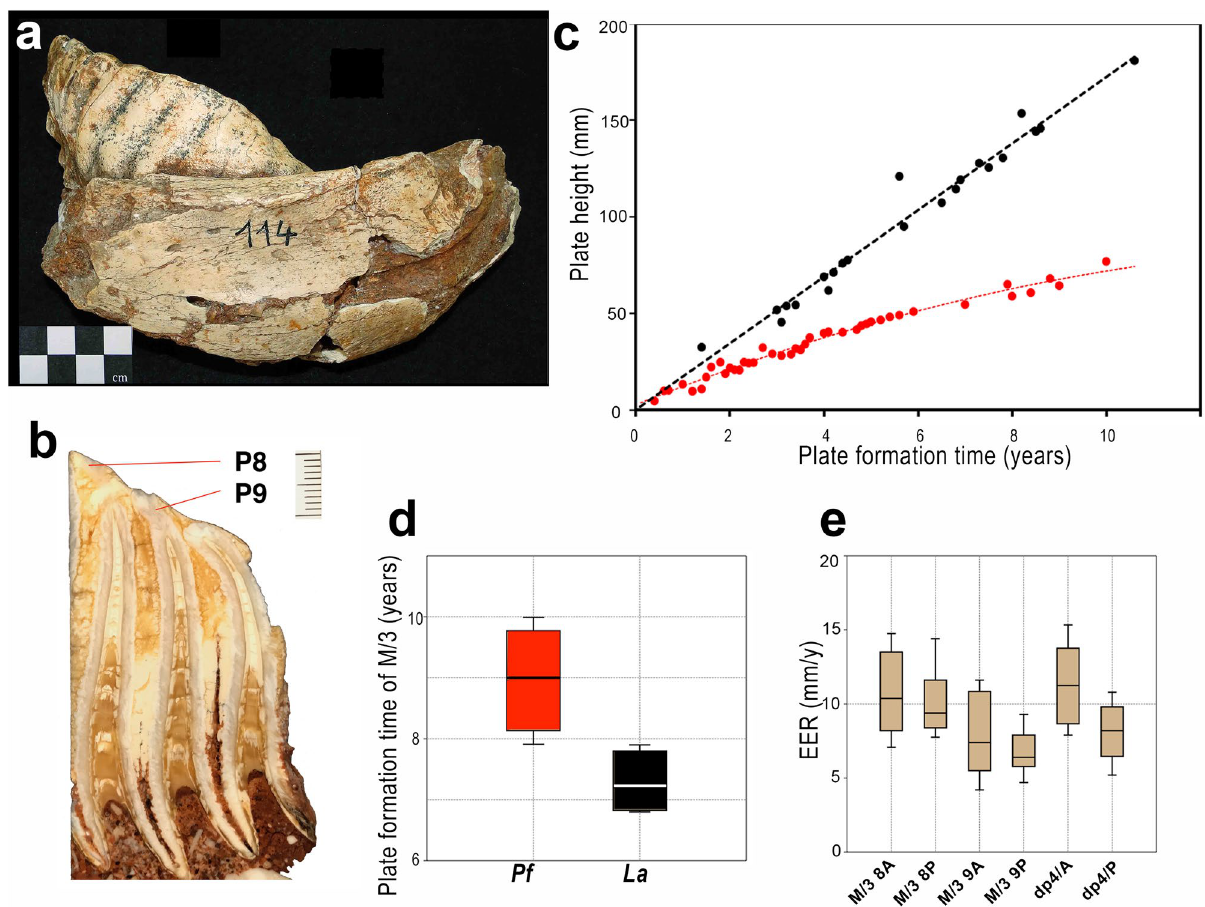
Figure 6. Molar growth pattern in P. falconeri . ( a ) Fragment of lower mandible with the P. falconeri M/3 (CAT- 114) used in molar analysis (graphic scale 4 cm); ( b ) longitudinal section of the posterior part of M/3 (CAT-114) showing the measured plates 8 and 9 (Graphic scale 1 cm); it is still unworn, roots are closed. ( c ) Growth in plate height plotted against PFT (years) for upper and lower dentition together; black dots: continental elephants ( M. columbi 32 ; P. antiquus IPS-B1-L1-82167, the last supposed sister taxon of both insular taxa P. cypriotes and P. falconeri ); red dots: insular elephants ( P. cypriotes , Cyprus 32 ; P. falconeri , Sicily). ( d ) Box-and-whisker plots for PFT of M/3 (red P. falconeri ; black L. africana 38 ). Mean values correspond to the mean of PFT of the lamellae of the different plates (Supplementary material 7). Horizontal lines denote the median, boxes the interquartile range (25–75 percent quartiles), and whiskers the maximum and minimum values; percentile ranks are computed by linear interpolation between the two nearest ranks. ( e ) Box-and-whisker plots for EER (mm/y) of the different P. falconeri lamellae and plates studied; EER decreases posteriorly. Horizontal lines denote the median, boxes the interquartile range (25–75 percent quartiles), and whiskers the maximum and minimum values; percentile ranks are computed by linear interpolation between the two nearest ranks (Supplementary material